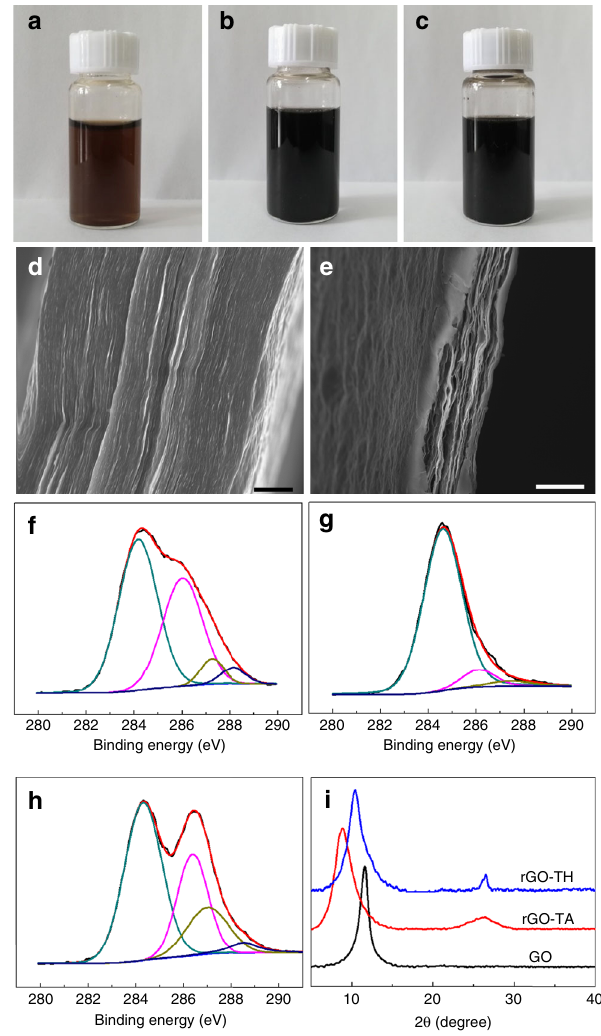
Fig. 1 Structure characterization of GO-based membranes. a – c Photos of GO dispersion ( a ), rGO – TA dispersion ( b ), and rGO – TH dispersion ( c ). d, e Typical cross-sectional SEM images of GO ( d ) and rGO – TH membranes ( e ). f – h C 1 s XPS spectra of GO ( f ), rGO – TH ( g ), and rGO – TA ( h ) membranes. i XRD patterns of GO, rGO – TA, and rGO – TH